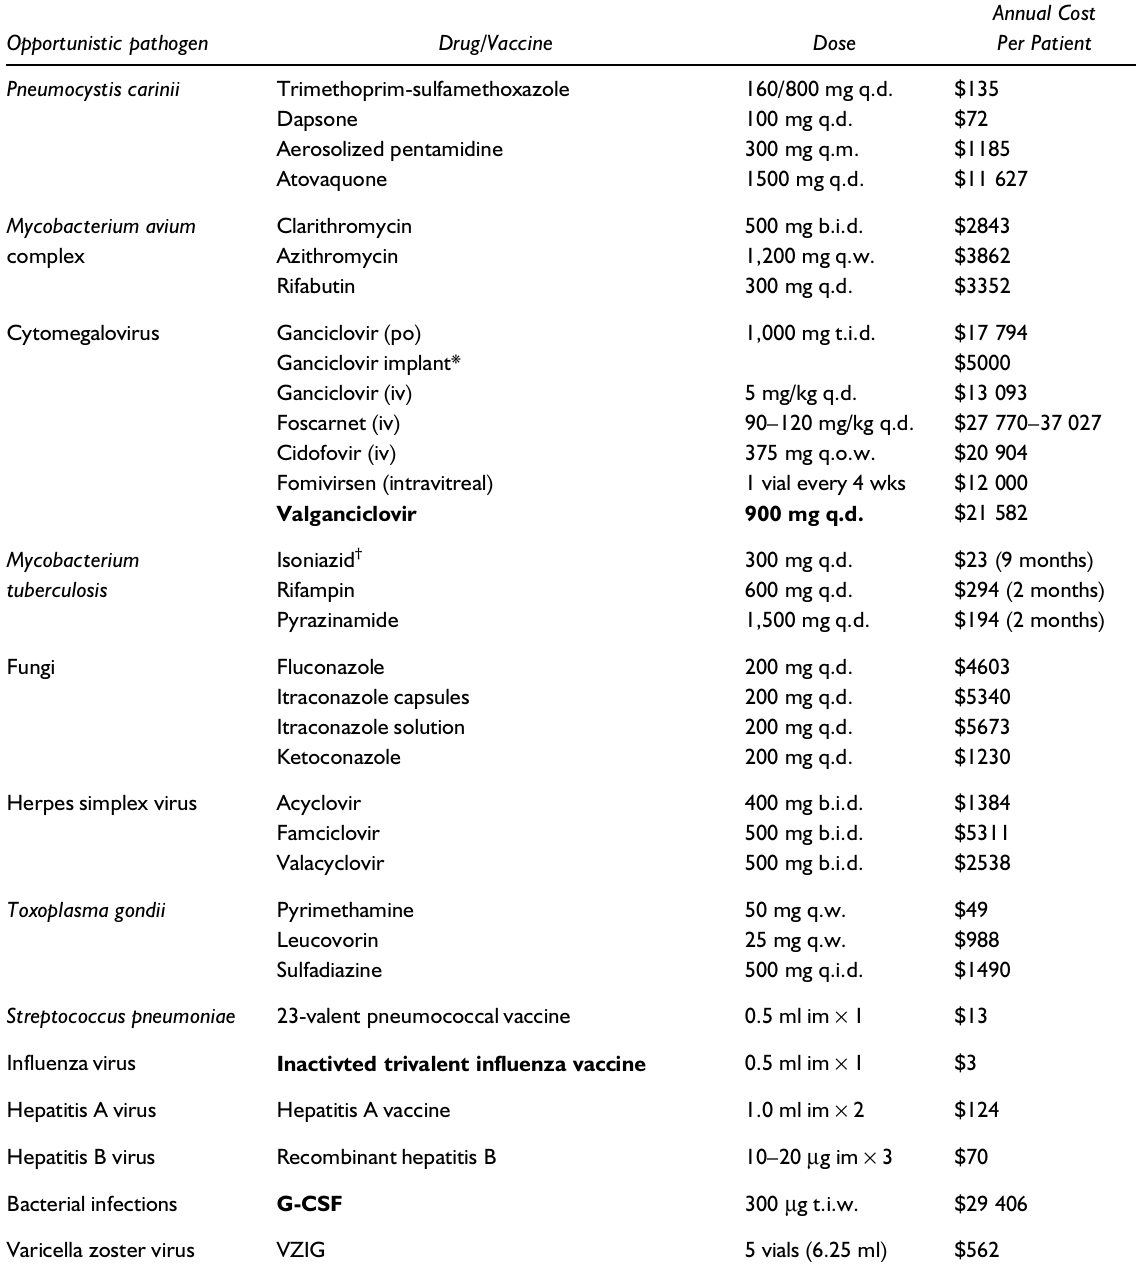
Table 9 Wholesale acquisition costs of agents recommended for the prevention of opportunistic infections in adults infected with human immunodeficiency